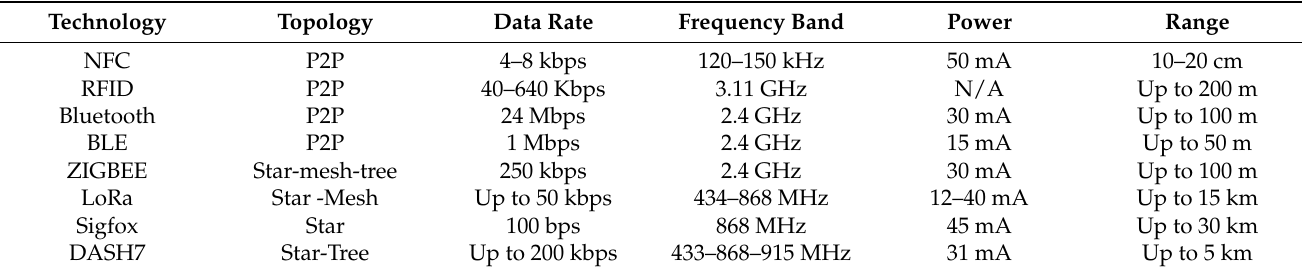
Table 1. A Comparison Between Wireless Communication